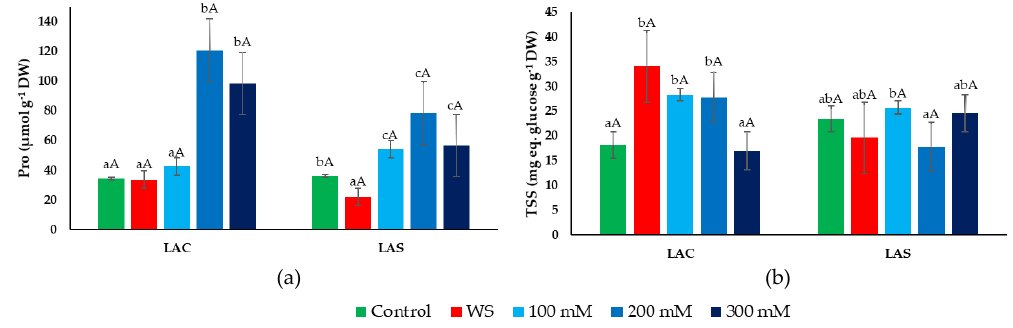
Figure 7. Leaf contents of proline (Pro) ( a ) and total soluble sugars (TSSs) ( b ) in L. angustifolia var. ‘Codreanca’ (LAC) and var. ‘Sevtopolis’ (LAS) plants after 30 days of growth under control conditions, in the presence of the indicated NaCl concentrations or subjected to water stress (WS) (completely withholding irrigation). DW, dry weight. Bars represent means ± SE ( n = 5). Di ff erent lowercase letters above the bars indicate significant di ff erences between treatments for each variety, and di ff erent uppercase letters indicate significant di ff erences between the two varieties for plants undergoing the same treatment, according to the Tukey test ( α = 0.05).